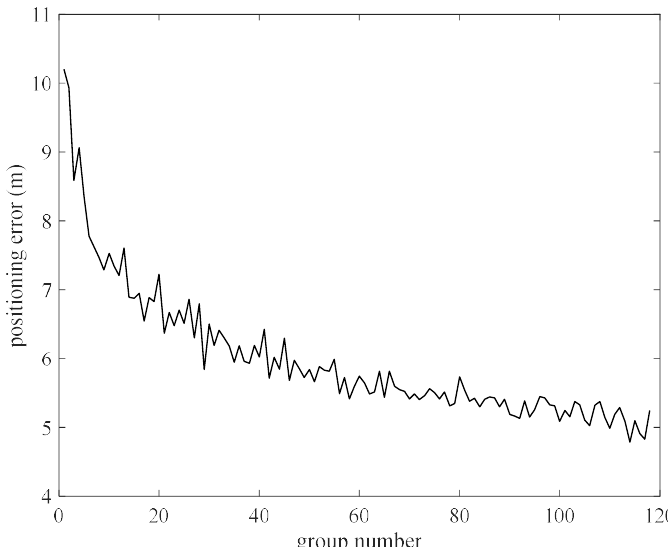
Figure 7. The positioning error changed with different group number.